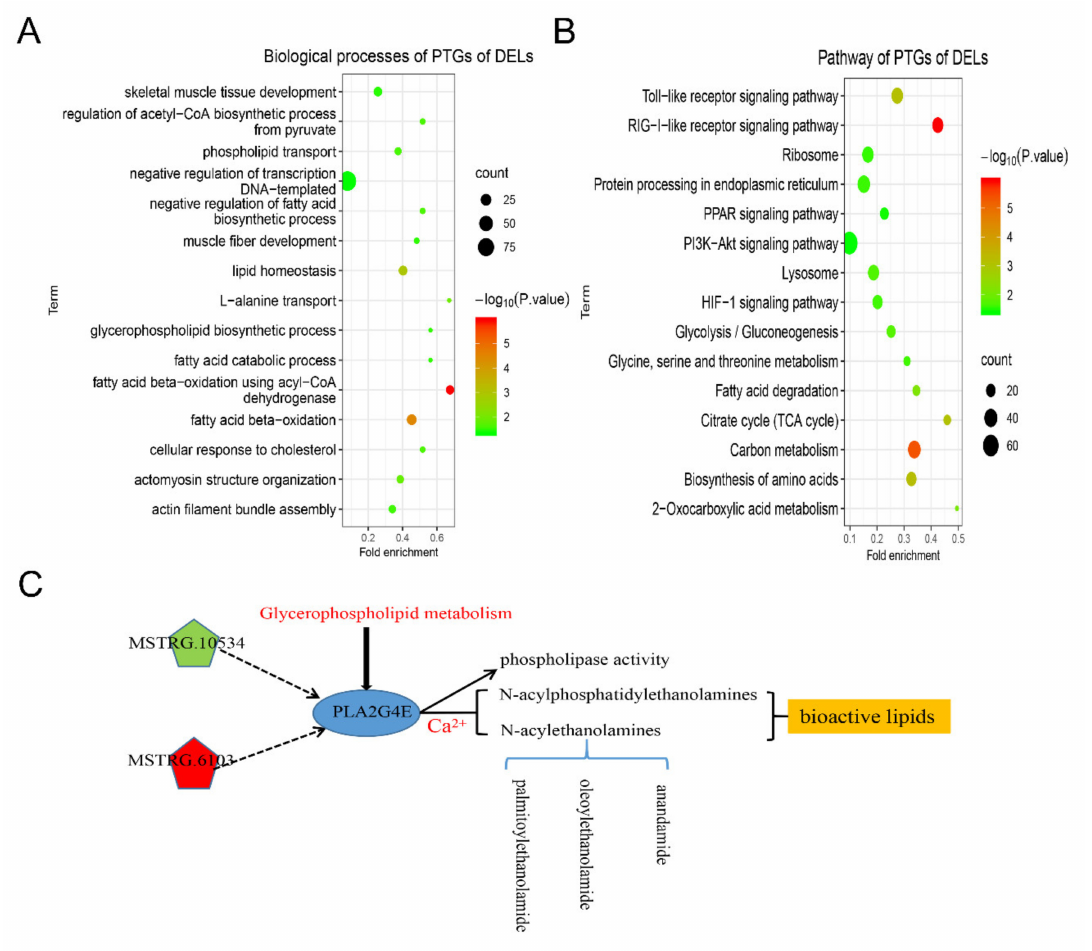
Figure 5. Gene ontology and pathway analysis of the potential target genes (PTGs) of DE lincRNAs. ( A ) Biological processes of PTGs of DE lincRNAs; ( B ) pathways of PTGs of DE lincRNAs; ( C ) the interaction of DEPTGs and DE lincRNAs. The green pentagon represents that the DEL is downregulated in Wei pigs, the red pentagon represents upregulation in Wei pigs, and the blue circle indicates